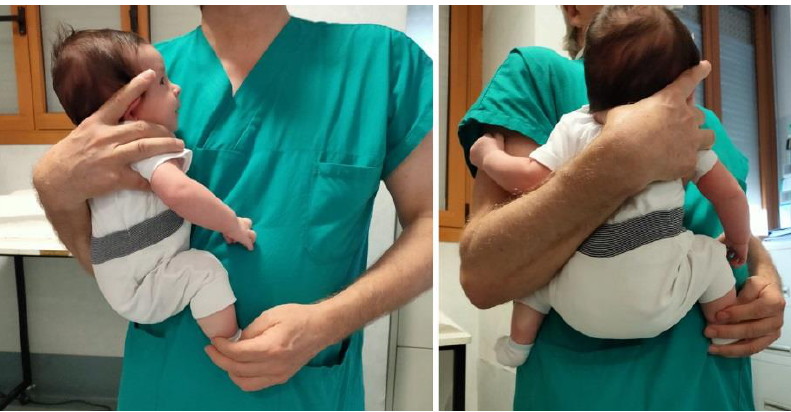
Figure 3. Hip position in a 2-month old infant when held on the caretakers’ side. Flexion is approximately 100° and abduction 60°.